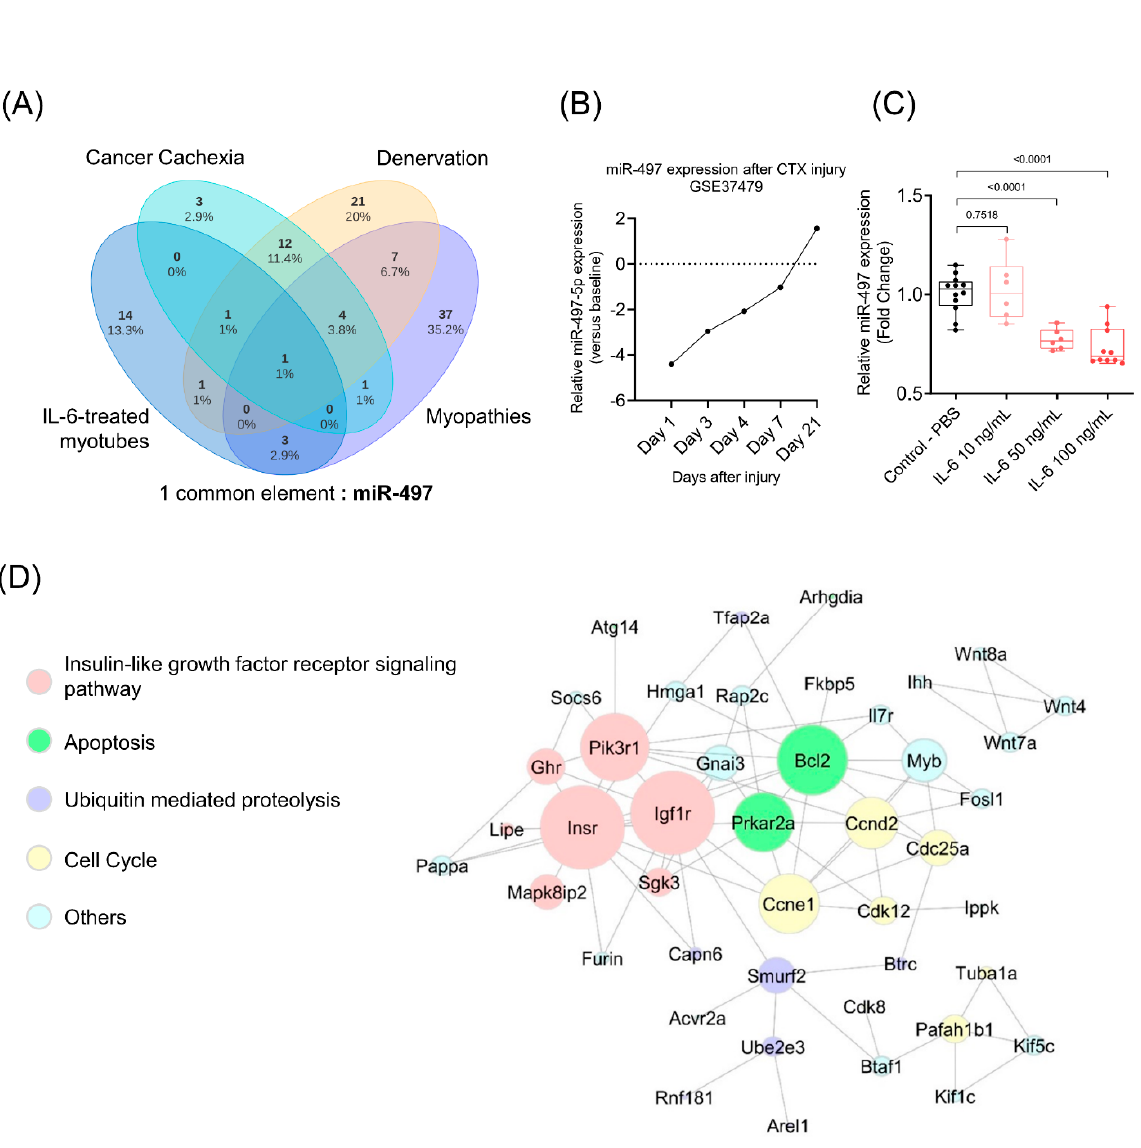
Figure 3. miR-497-5p is deregulated in skeletal muscle cells in different atrophic conditions. ( A ) Venn diagram showing the miR-497-5p as a common element between our data, cancer cachexia, primary muscle disorders, and other catabolic conditions. ( B ) miR-497 expression levels after 1, 3, 4, 7, and 21 days of cardiotoxin injury (CTX). Relative miRNA expression versus baseline (GSE37479). ( C ) MiR-497-5p expression levels in differentiated C2C12 myotubes treated with three different concentrations of IL-6 vs. control (PBS). RT-qPCR data are presented as fold change (2 −ΔΔ Ct ) relative to MammU6. ( D ) Interactome between the predicted miR-497-5p target genes. Nodes represent miR-497-5p target genes according to the biological process. The larger the nodes, the higher the degree of interactions identified. Nodes with no connections were excluded. STRING v10.5.1 was used to generate protein interactions, and the network interactions were visualized using Cytoscape v3.4.0.